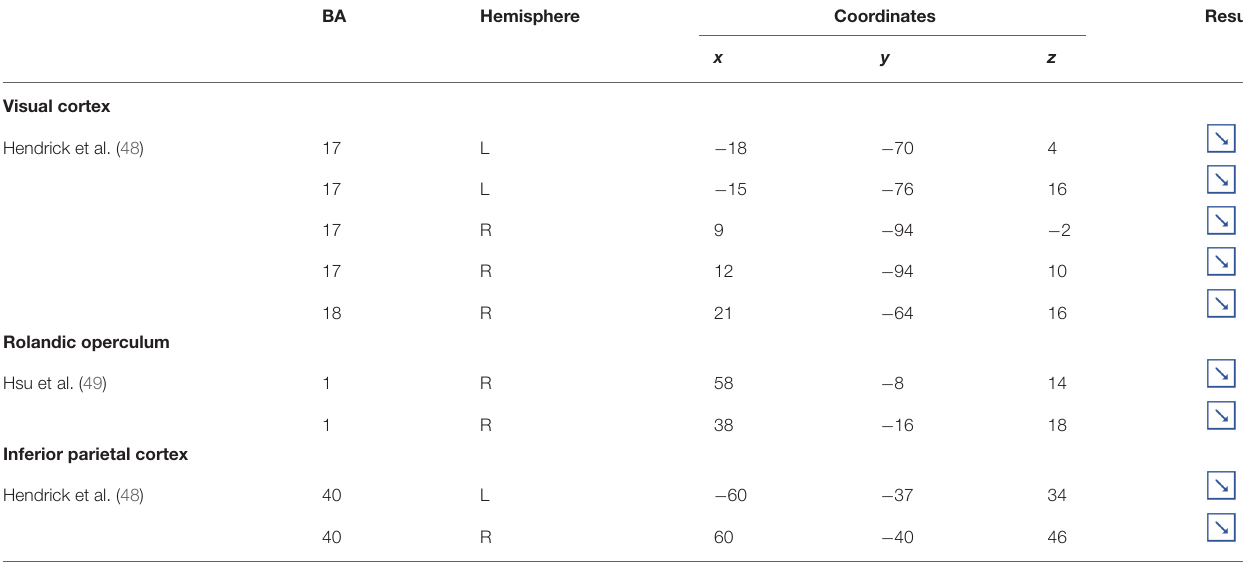
Blue arrows indicate hypoactivity in obese in comparison with lean participants. Red arrows indicate hyperactivity in obese in comparison with lean participants. BA, Brodmann area.